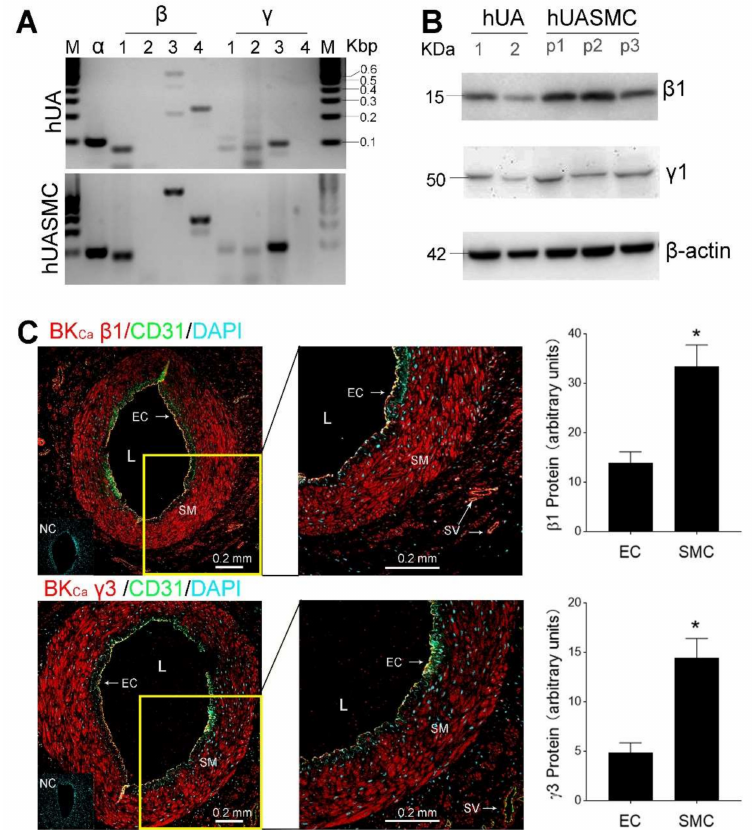
Figure 1. BK Ca channel expression in human uterine artery. ( A ) Expression of mRNAs of BK Ca subunits in human uterine artery (hUA, upper panel) and cultured primary hUA smooth muscle cells (hUASMC, lower panel). Steady-state mRNAs of α , β 1–4, and γ 1–4 subunits were detected by RT-PCR. The amplicons were sequencing confirmed. M, 100 bp DNA ladder. ( B ) β 1 and γ 1 proteins detected by immunoblotting in hUA from two women and primary hUASMC in three passages (P). ( C ) Localization of β 1 and γ 3 proteins by immunofluorescence microscopy. SMC; smooth muscle cells; EC; endothelial cells; L; lumen; NC: negative control; SV; small vessels. Graph summarized levels of EC and SMC β 1 and γ 3 proteins ( n = 3). * p <